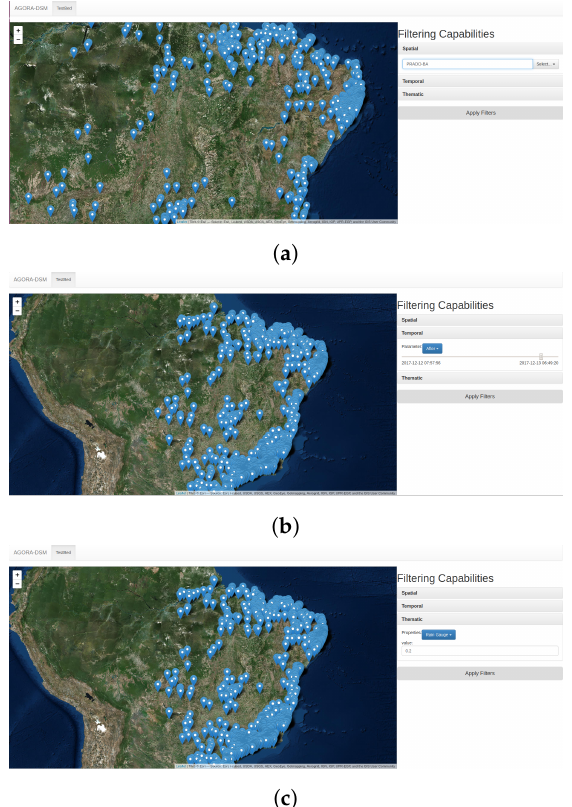
Figure 23. Prototyping Web App—Filtering Capabilities Parameters. ( a ) Spatial Parameters; ( b ) Temporal Parameters; ( c ) Thematic